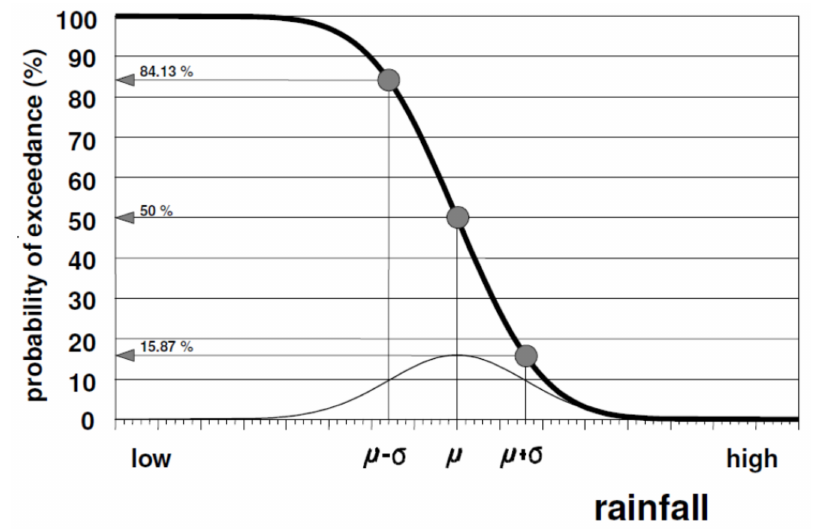
Figure 1. Exceedance probability as a function of